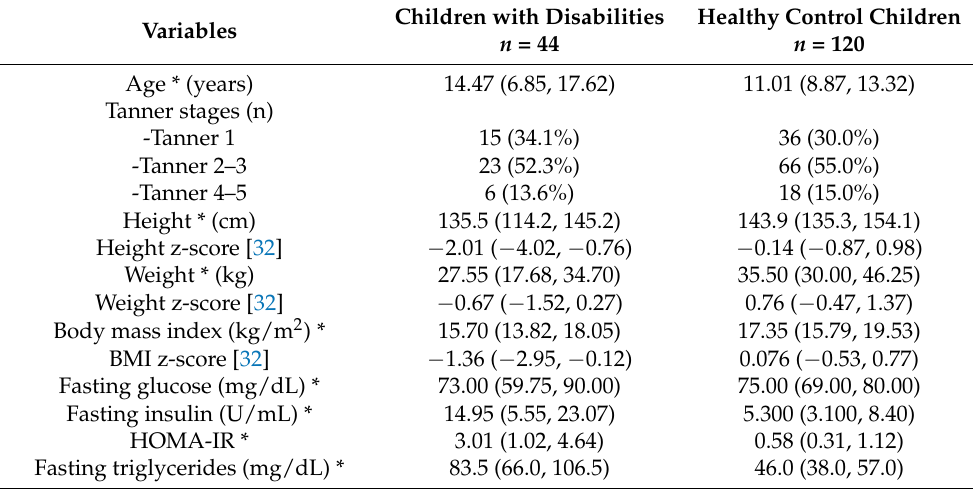
Table 1. Clinical features of the patients and controls and variables included in the